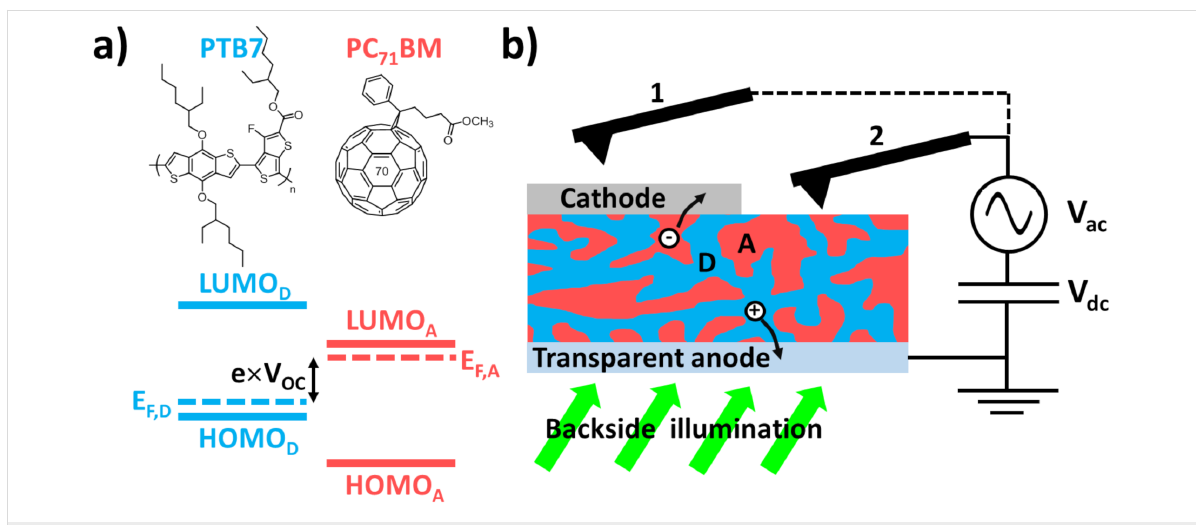
Figure 3: (a) Top: chemical structures of PTB7 (electron donor, D) and PC 71 BM (electron acceptor, A). Bottom: illustration of the type-II energy level alignment between the electron donor and the electron acceptor. The open-circuit voltage ( V OC ) is determined by the splitting of the quasi-Fermi levels of holes and electrons upon illumination, symbolized by dotted lines. (b) Organic BHJ solar cell and experimental configuration. The sample is illuminated in backside geometry. The transparent anode, the hole collecting electrode made of indium tin oxide coated with PEDOT:PSS, is grounded. The modulation and compensation bias are applied to the tip. The pp-KPFM measurements are performed either on top of the cathode (1: single-point spectroscopy) or on top of the bare organic layer (2: data-cube